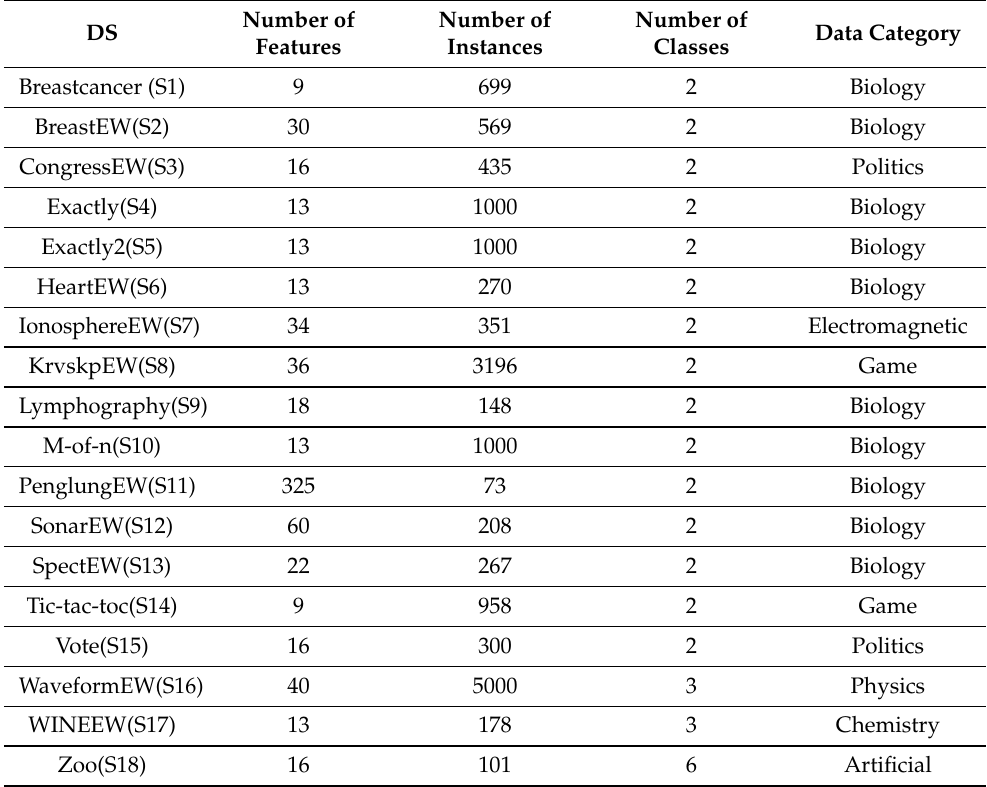
Table 2. Description of UCI datasets.